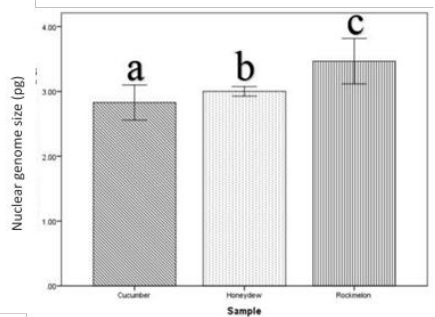
Figure 2: Average mean of nuclear genome size of three Cucumis